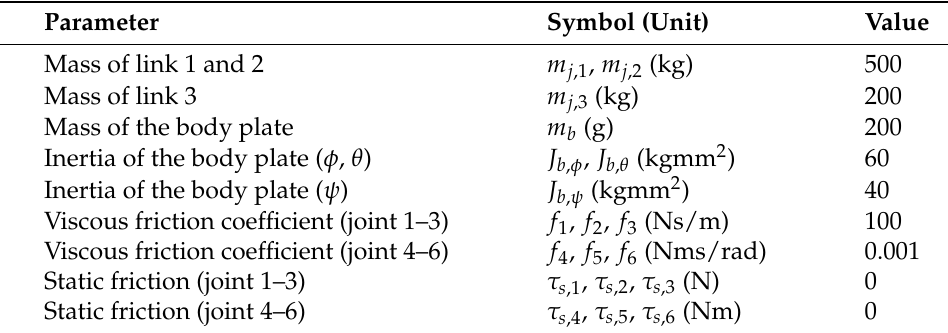
Table 1. Notation of basic test bench parameters.